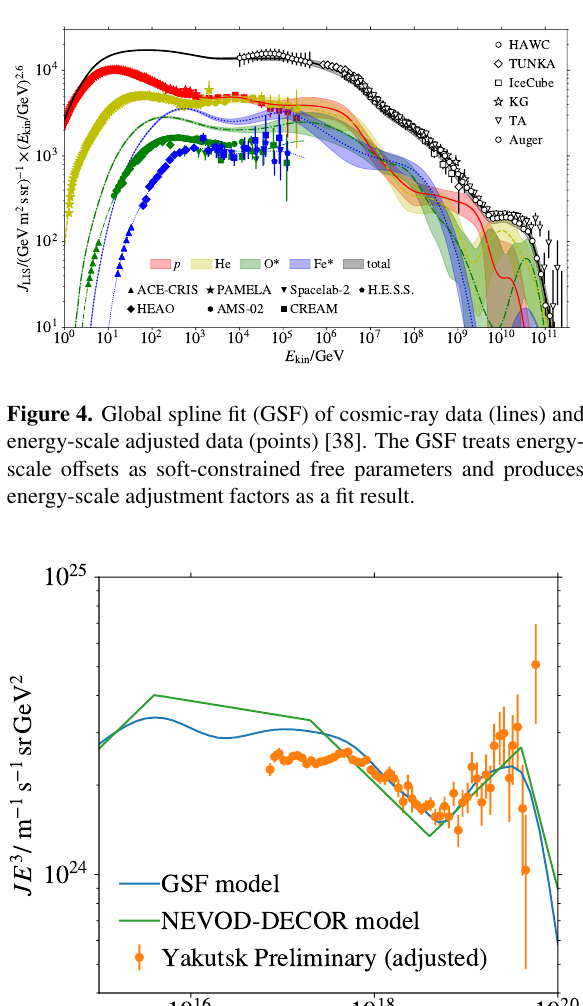
found a relative energy-scale shift of 10.4 % between the two experiments, see Fig. 3. The reference energy scale E ref is placed between the two experiments. The scaling factor for IceCube was taken from an up- dated Global Spline Fit (GSF) model [38], see Fig. 4. The GSF also uses cross-calibration internally, with a reference energy scale E ref,GSF / E ref = 0 . 948 / 0 . 88 ≈ 1 . 08. The scal- ing factor for IceCube is E IceCube / E ref,GSF × E ref,GSF / E ref = 1 . 10 × 1 . 08 ≈ 1 . 19. The factor for Yakutsk is obtained by matching a pre- liminary update of their all-particle flux against the GSF model, see Fig. 5, to obtain a ratio E Yakutsk / E ref,GSF × E ref,GSF / E ref = 1 . 15 × 1 . 08 ≈ 1 . 25. The factor for NEVOD- DECOR is obtained by comparing their custom all-particle flux parameterization with GSF (see same figure). The two models di ff er locally, which could be translated into energy-scale o ff sets within ± 2 %, but no global o ff set is apparent. The energy scale of NEVOD-DECOR is